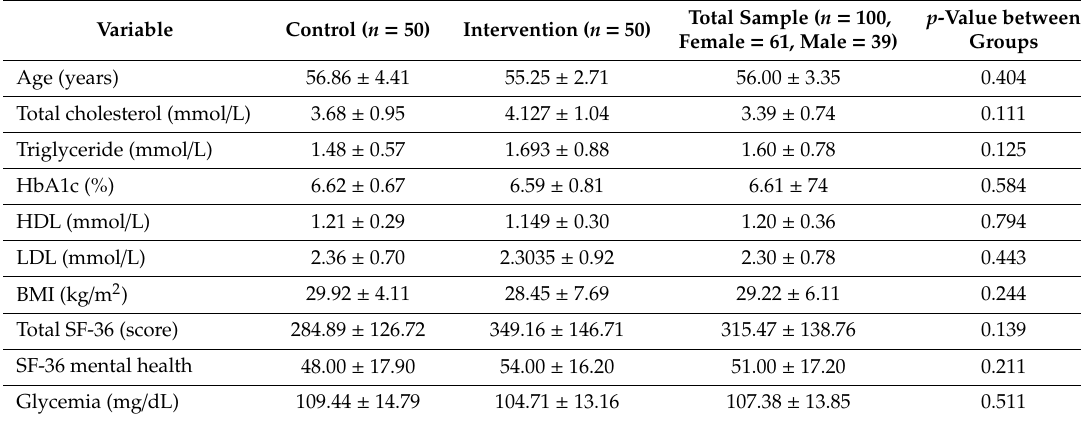
Table 1. Clinical characteristics of the sample.